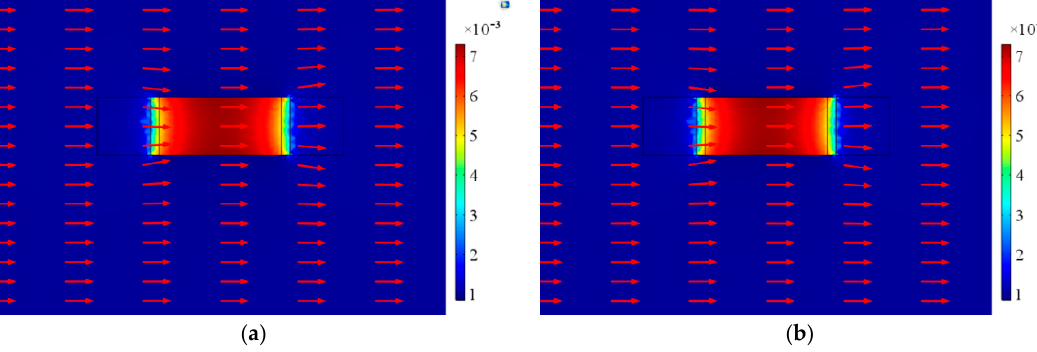
Figure 16. Magnetic flux distribution on ( a ) the upper and ( b ) lower surfaces of Terfenol-D under a uniform magnetic field.